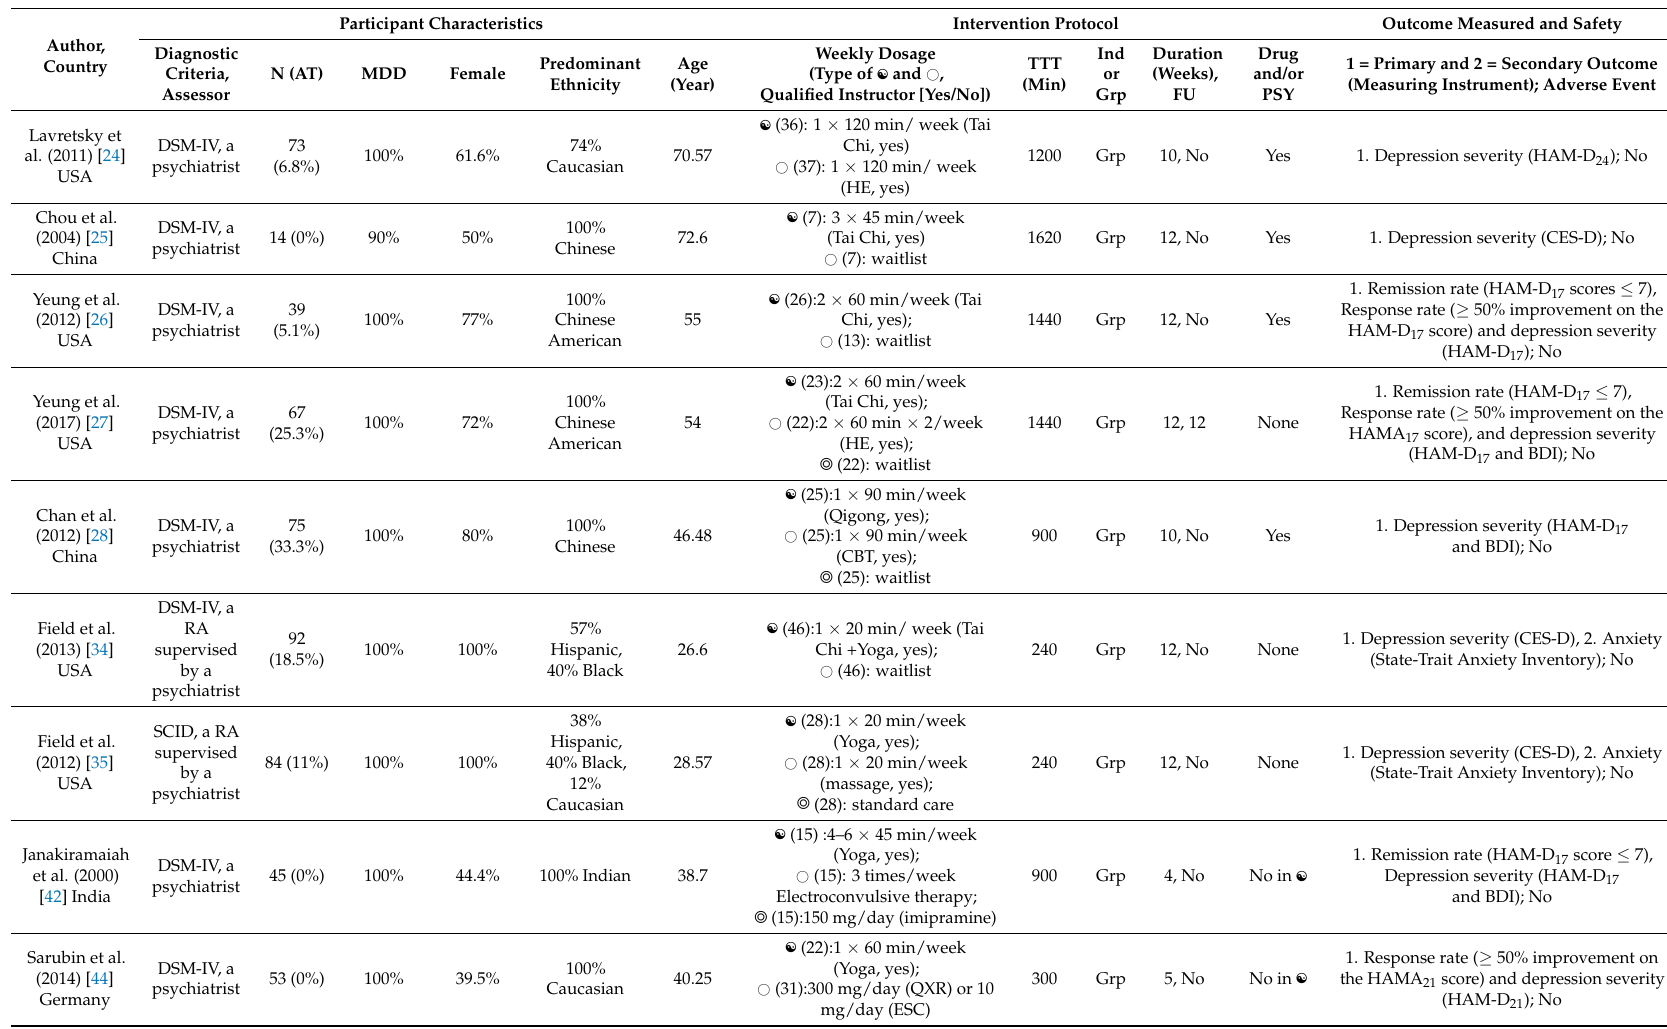
Table 1. Characteristics of all randomized controlled trials.